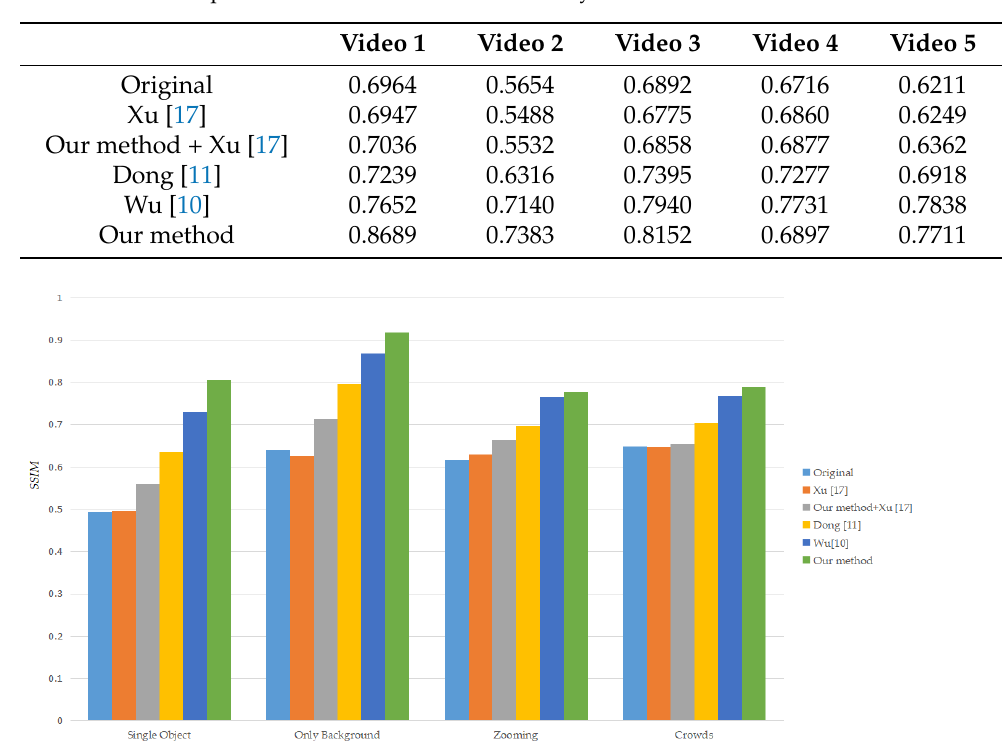
Table 4. SSIM Comparison of different methods for shaky videos with crowds.